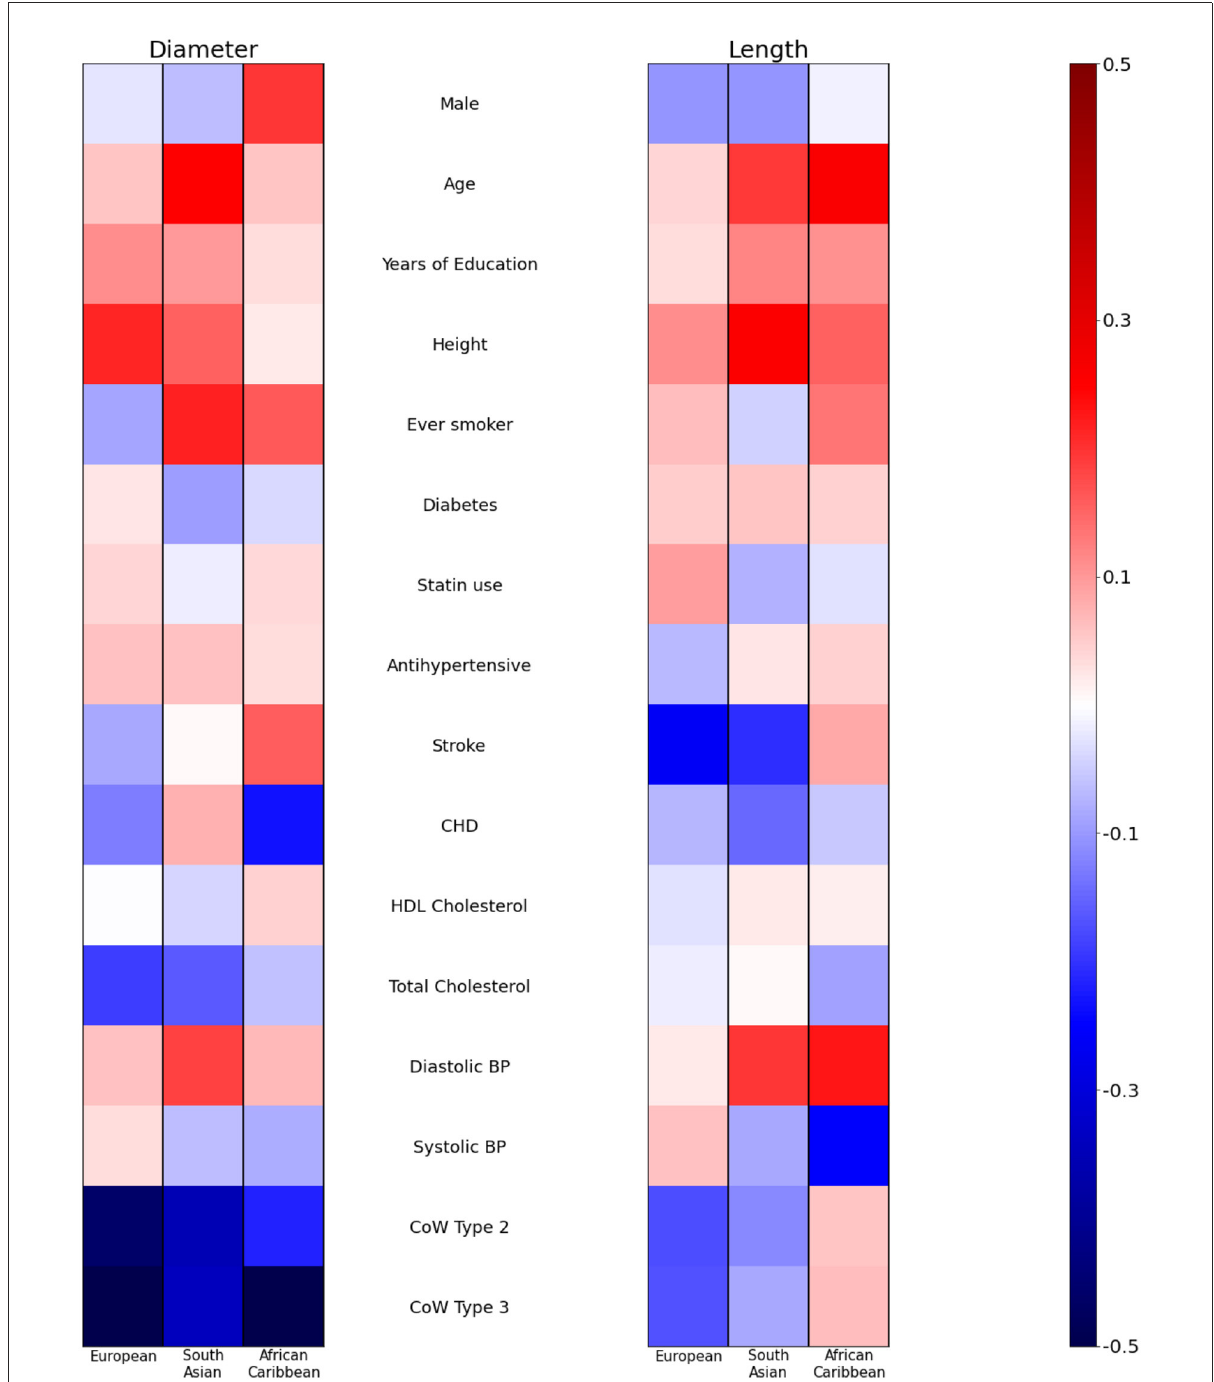
FIGURE2 Cohen’s D (effect size) of demographic and cardiovascular risk factors on basilar artery geometric characteristics. A separate model is fitted for each ethnicity adjusting simultaneously for all covariates. CoW, Circle of Willis; CHD, Coronary Heart Disease; BP, Blood pressure.